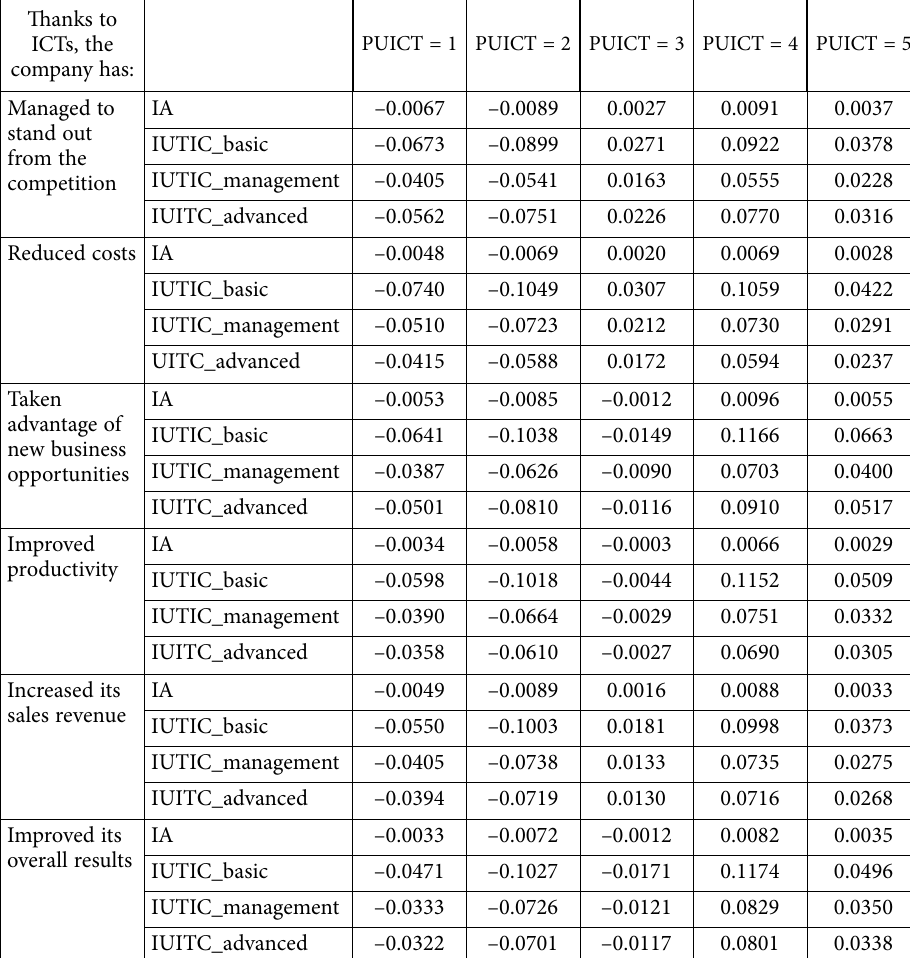
Table 5. Marginal effects for ordered logistic regressions (source: own